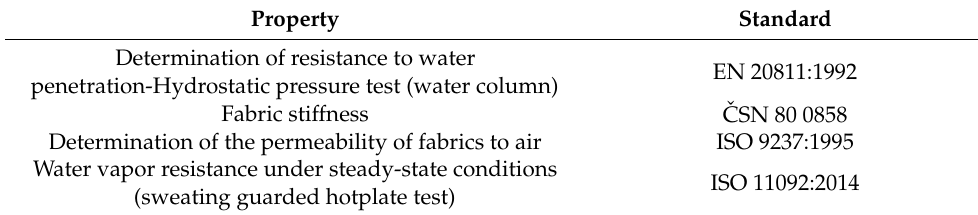
Table 3. Standards employed to evaluate the properties of the coated textiles. Property Standard Determination of resistance to water EN 20811:1992 penetration-Hydrostatic pressure test (water column) Fabric stiffness ˇCSN 80 0858 Determination of the permeability of fabrics to air ISO 9237:1995 Water vapor resistance under steady-state conditions ISO (sweating guarded hotplate test)